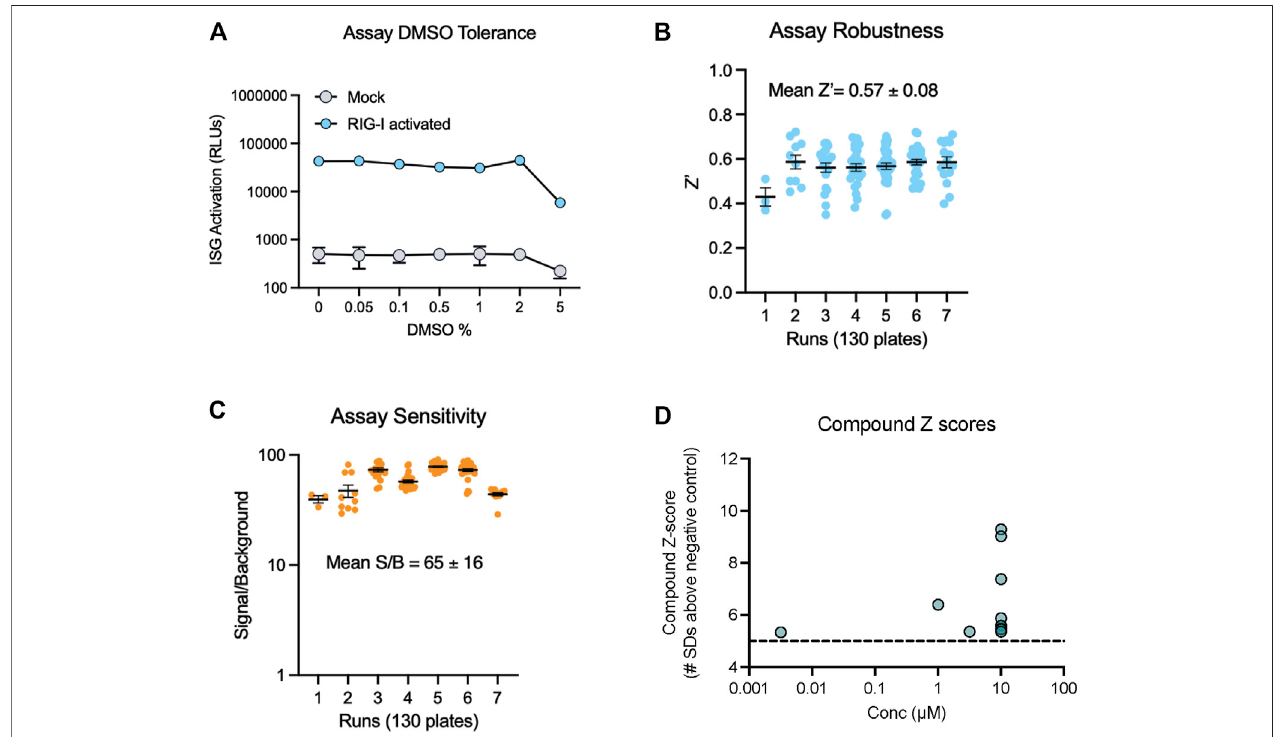
FIGURE 2 | Miniaturization and validation of RIG activity HTS assay in 384 well plate. (A) DMSO tolerance of HEK293 RIG-I cell line as measured by luciferase activation with positive control RIG-I agonist (B,C) Luciferase activity was measured in cell lysates as per manufacturer ’ s recommendations at 24 h post treatment with three compound libraries across 8 doses- the FDA approved drug collection, a LOPAC collection and a collection of natural product derived compounds from Microsource. Screening data from 7 independent runs totaling 130 plates show (B) high Z ′ values, (C) good signal to noise ratios. (D) Compound Z-scores of hits (at any concentration) in the FDA library de fi ned as number of standard deviations (SDs) above the mean of negative control